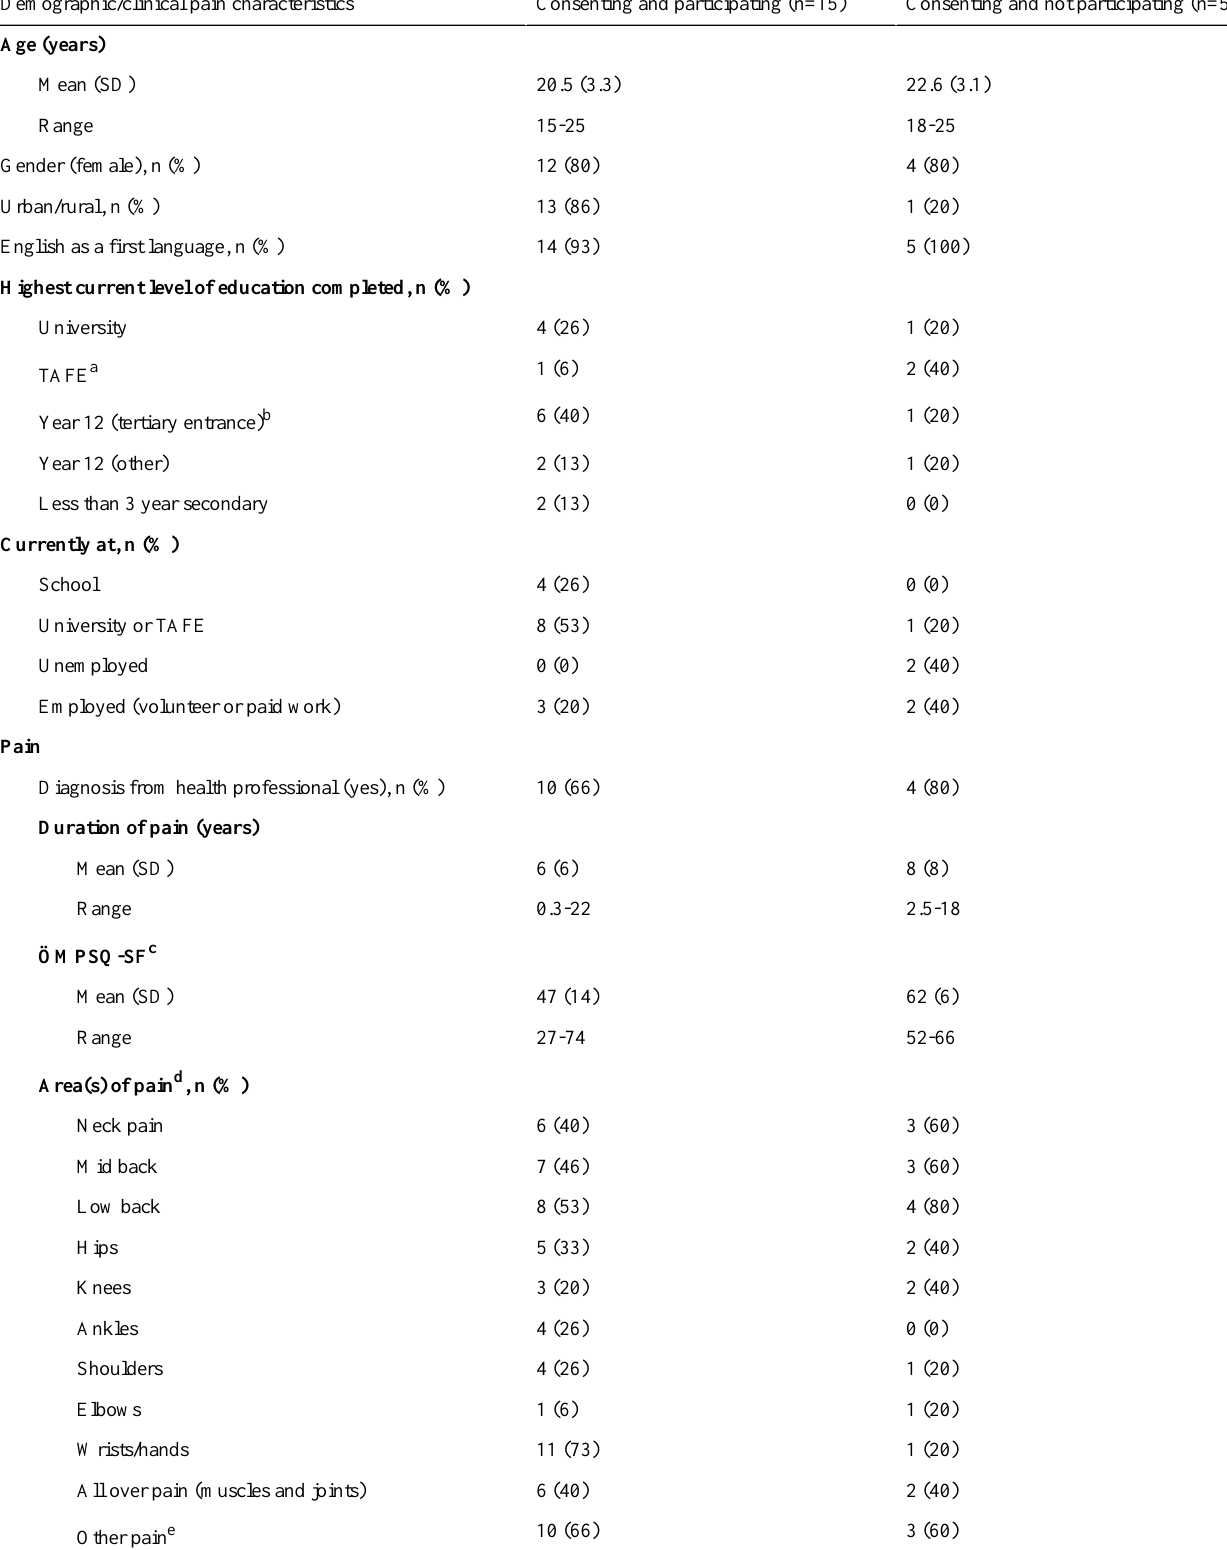
Table 2. Demographic and clinical pain characteristics of consenting participants